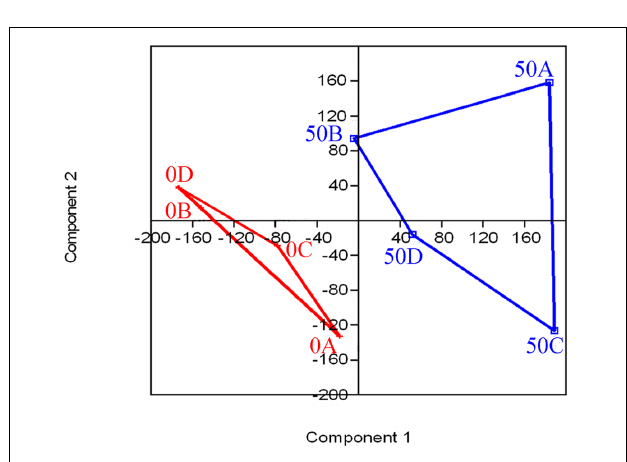
FIGURE 4 | Principal component analysis of the relatedness of PCR-DGGE banding patterns from BAC samples before phenol